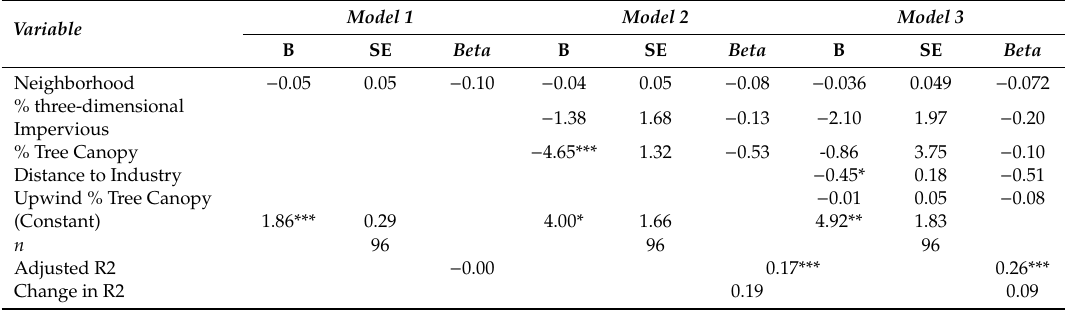
Table 10. Regression analysis for UHI temperatures at 4 p.m. using three-dimensional approach in eight Chicago neighborhoods in summer